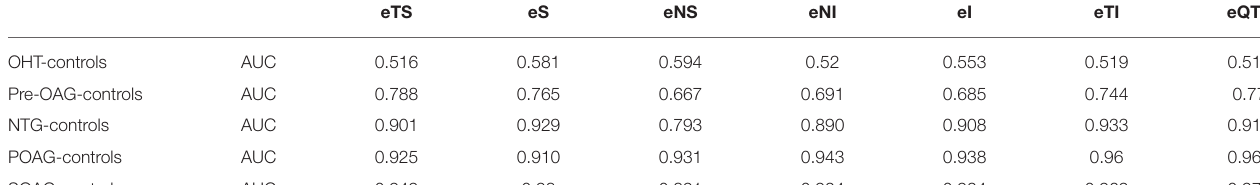
TABLE 8 | AUC of ROC analysis of extended qualitative RGCL thickness score for each subgroup (OHT, pre-OAG, NTG, POAG, SOAG vs. controls, respectively): total (eQTV, extended qualitative total value) and sectorial (eTS, extended temporal superior; eS, extended superior; eNS, extended nasal superior; eNI, extended nasal inferior; eI, extended inferior; eTI, extended temporal inferior).